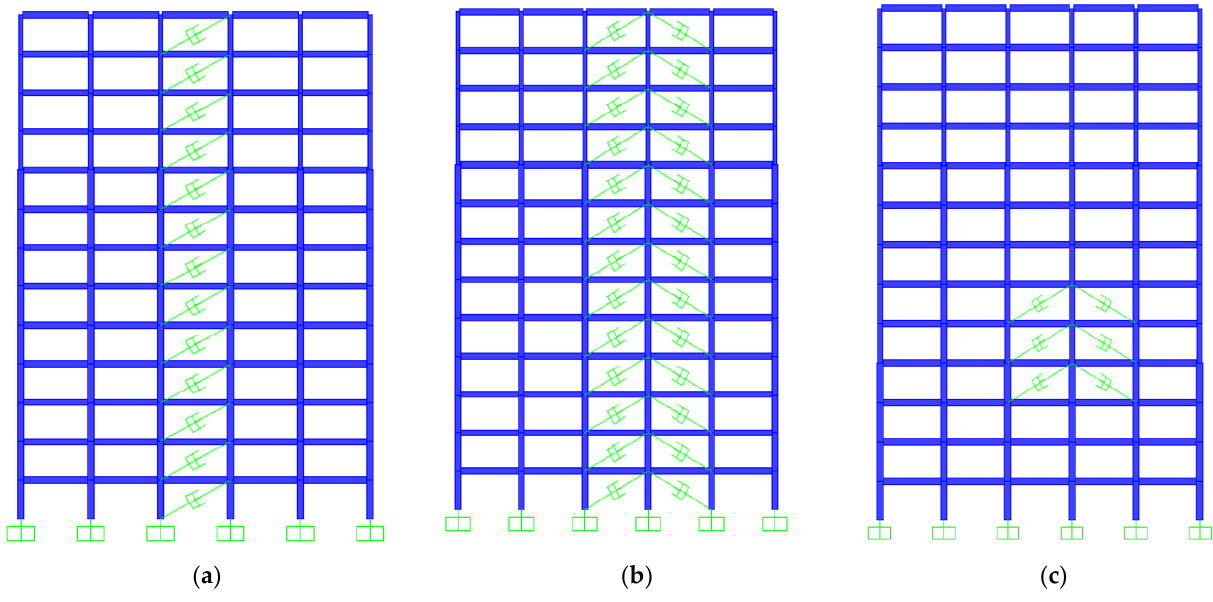
Figure 4. ( a ) Viscously damped frame in the central bay, ( b ) viscously damped frame in two inner bays, and ( c ) Viscously damped frame only in certain stories.